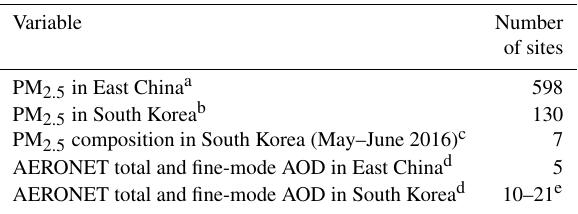
Table 2. KORUS-AQ aircraft observations used in this work (May– June